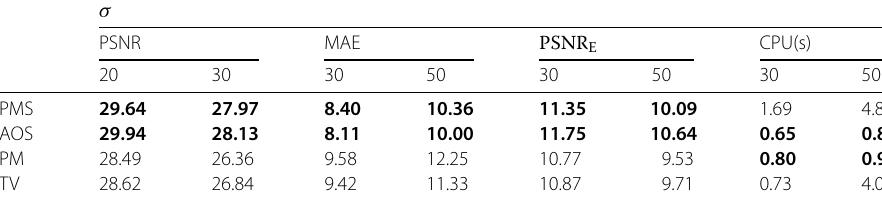
Table 2 PSNR, MAE, PSNR E , and CPU time (seconds) of all methods for the Lena image (300 × 300) σ PSNR